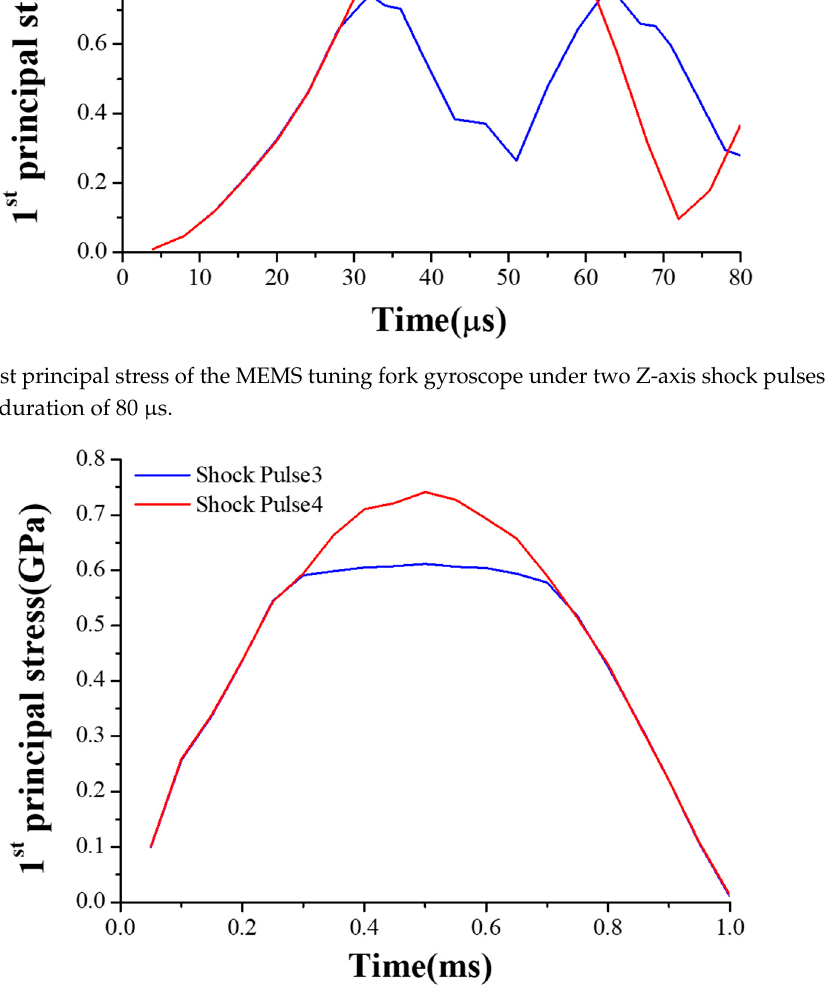
Figure 8. First principal stress of the MEMS tuning fork gyroscope under two Z-axis shock pulses with a shock pulse duration of 1 ms.